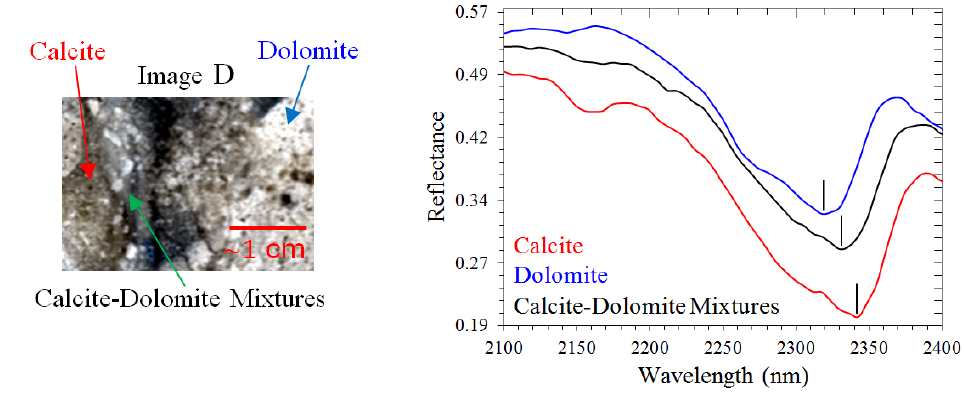
Figure 4. Example of SisuCHEMA spectra ( right ) of calcite (red curve), dolomite (blue curve) and calcite-dolomite mixtures (black curve) derived from different pixel locations of image D ( left ). The curves show shift in wavelength position of carbonate absorption feature.